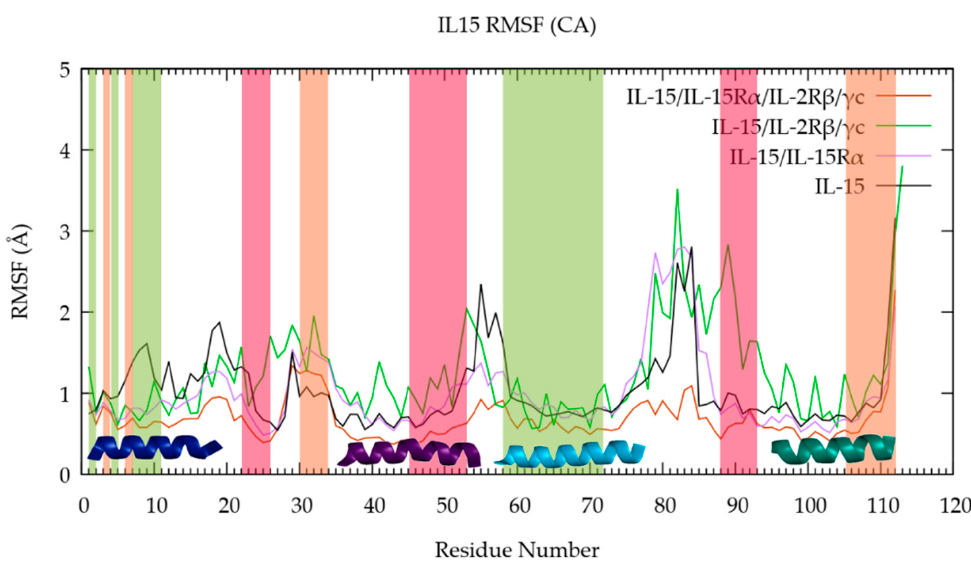
Figure 4. RMSF of C α carbon atoms of IL-15 residues in the investigated multimeric models over the last 100 ns of the MD simulations. The shaded areas indicate the IL-15 interfaces residues interacting with IL-15R α (red), IL-12R β (green), and γ c (orange). Helices A (dark blue), B (purple), C (light blue) and D (teal) of IL-15 are also represented.